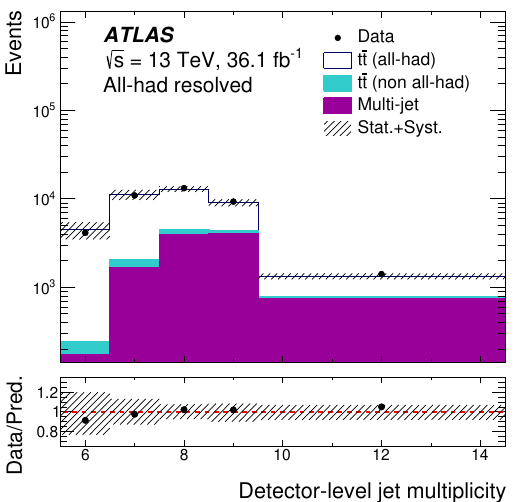
Figure 2 . Jet multiplicity in the SR. The signal prediction is based on the Powheg+Pythia 8 generator. The background is the sum of the data-driven multi-jet estimate and the MC-based ex- pectation for the contributions of non-all-hadronic t ¯ t production processes. Statistical uncertainties combined with systematic uncertainties are shown in hatching. Data points are placed at the centre of each bin and overflow events are included in the last